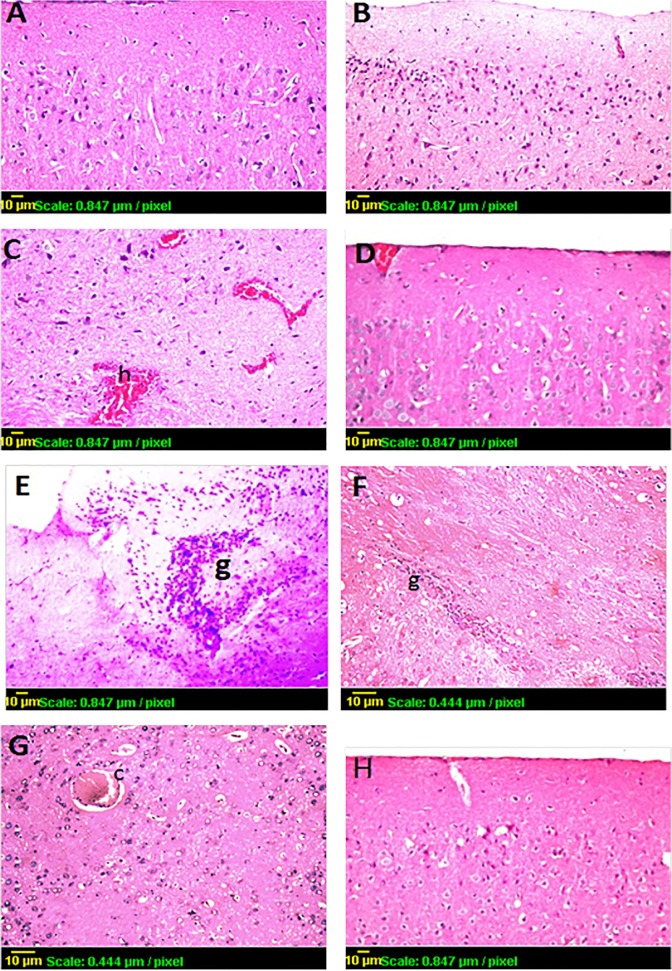
H & E staining of the cortices of rats belonging to the sham group (A), control group (B), 3-NPA-treated group (C), 17β-estradiol- and 3-NPA-treated group (D), genistein (5 mg/kg)- and 3-NPA-treated group (E), genistein (10 mg/kg)- and 3-NPA-treated group (F), genistein (20 mg/kg)- and 3-NPA-treated group (G) and genistein alone-treated group (H): A, B, D and H showed no histological alterations, C showed severe hemorrhage (h), E showed focal gliosis (g) F showed focal gliosis (g) and G showed congested blood vessel (C).